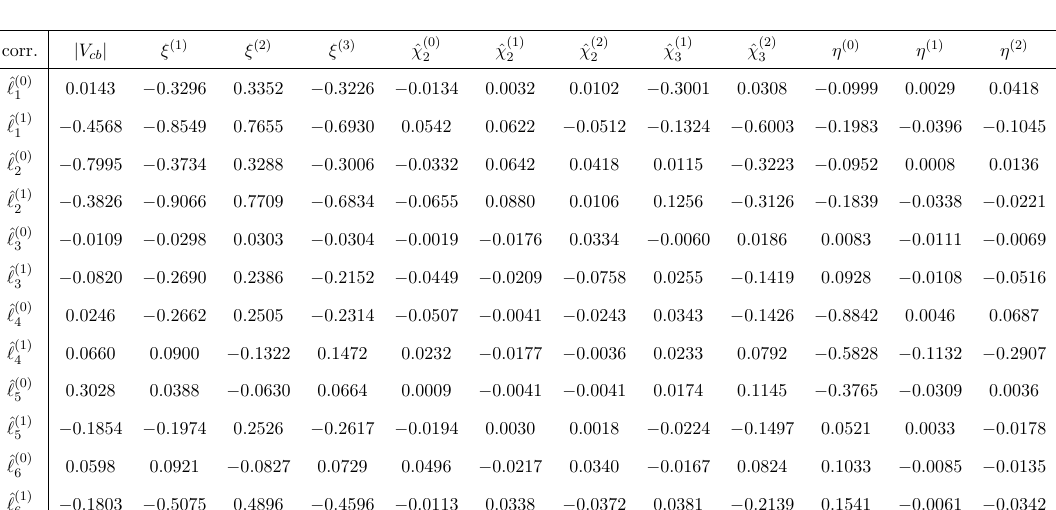
n o n ^ ‘ ( n ) { (cid:24) ( n ) ; ^ (cid:31) ( n ) 1{6